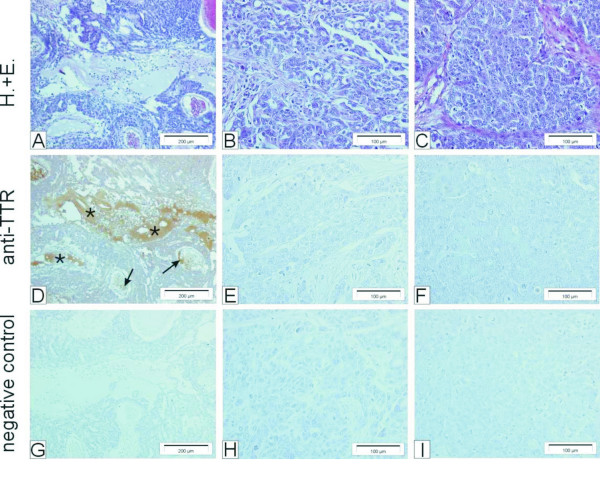
Histological sections from ovarian malignoma subjected to staining with H+E (A-C) or immunodetection of TTR (D-E). Diffuse TTR immunostaining was only detectable within blood vessels (arrows) or plasma insudations (asterisks) (D). No immunoreactivity was observed within epithelial cells of any tumour specimen (D-F)). Negative controls, which included the omission of the primary antibody, revealed no significant labelling (G-I).